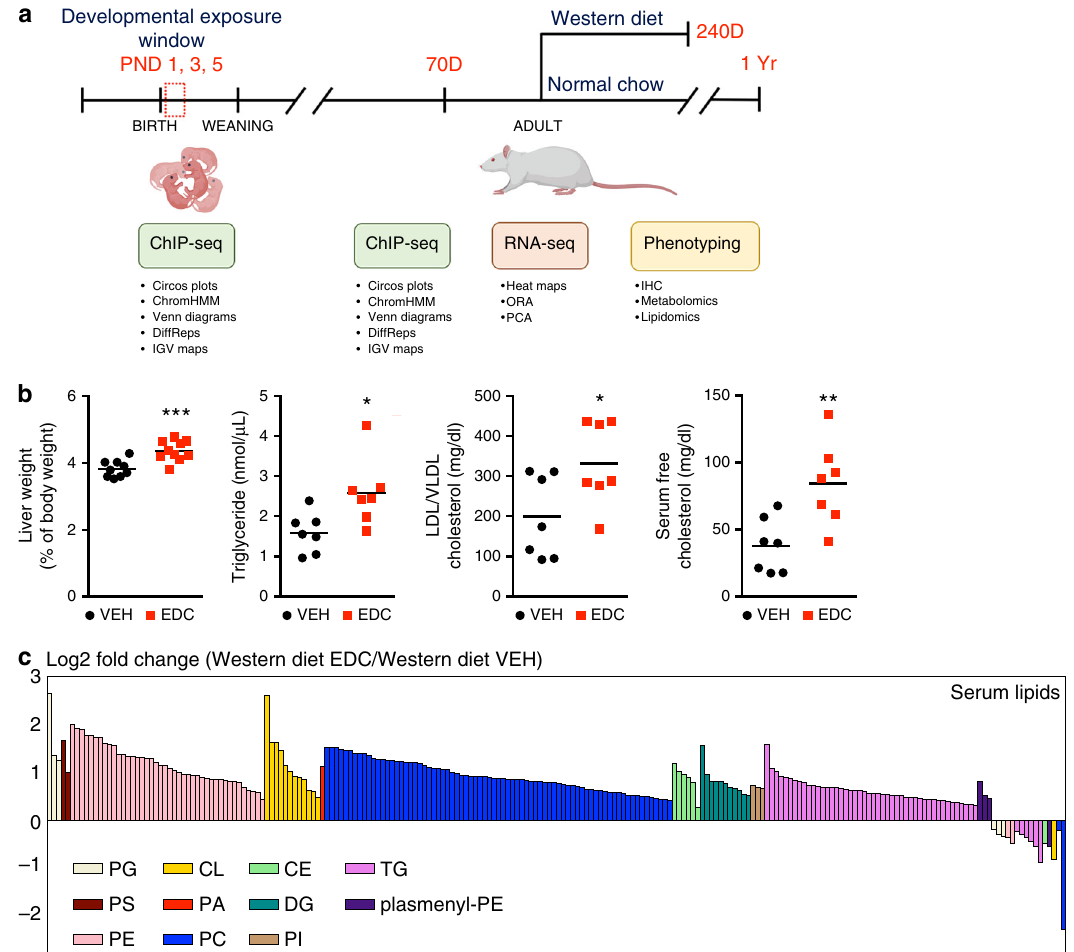
Fig. 1 EDC-induced metabolic reprogramming in the setting of a Western-style diet. a Schematic of the integrated longitudinal epigenomic, transcriptomic and metabolomic analyses performed across the life-course in a rat model of early-life (postnatal days (PND)1 – 5) exposure to the EDC bisphenol A. Techniques and analytic approaches utilized at each life-stage are shown. b Metabolic phenotyping of vehicle- and EDC-exposed animals fed a Western-style diet at D240. Black circles represent individual vehicle (VEH) and red squares represent individual EDC (EDC) animals. N = 7 biologically independent animals per treatment. The p values generated by t test are indicated. * p < 0.05; ** p < 0.01; *** p < 0.001. c EDC-exposure causes dyslipidemia in exposed animals fed a Western-style diet as seen in the targeted serum lipidomic analysis of vehicle- and EDC-exposed animals ( N = 5 biologically independent animals per treatment). This analysis identi fi ed phospholipid [phosphatidylglycerol (PG), phosphatidylserine (PS), phosphatidylethanolamine (PE), phosphatidic acid (PA), phosphatidylcholine (PC), and phosphatidylinositol (PI)], cardiolipin (CL), cholesteryl ester (CE), diacylglycerol (DG), triglyceride (TG), and plasmenyl-PE levels as signi fi cantly ( q < 0.25) increased in EDC-exposed animals on Western-style diet compared to VEH-exposed animals fed the same diet. Each bar is a different speci fi c lipid within a color-coded class for each lipid. Source data for b , c are provided as a Source data fi